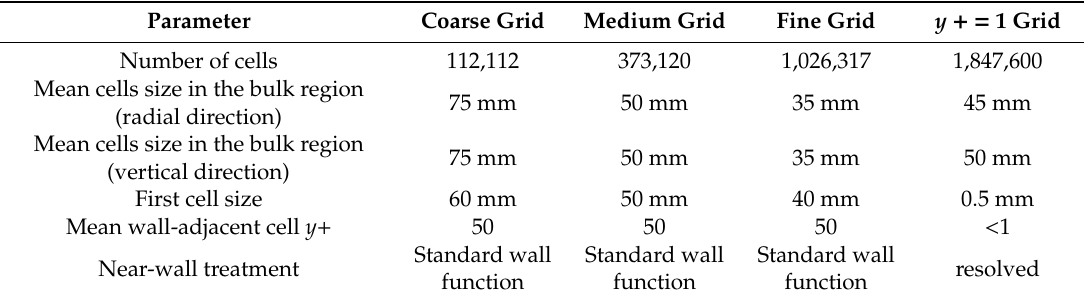
Table 3. Computational meshes.